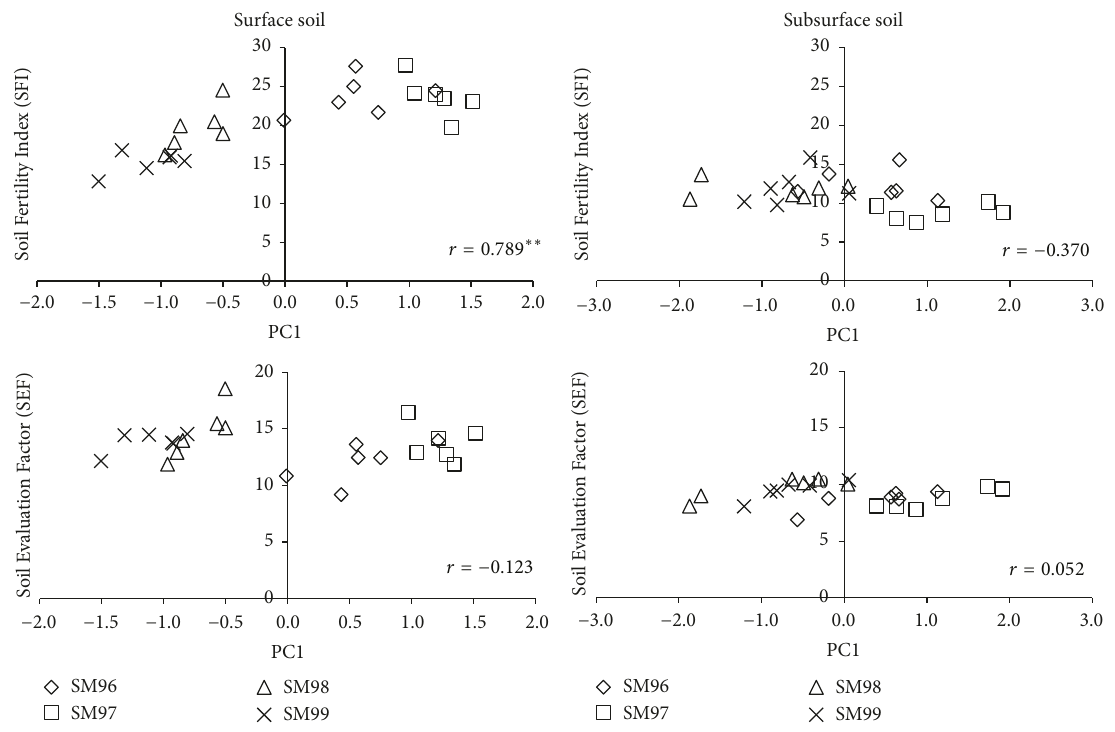
Figure 2: Relationship between PC1 score derived from PCA analysis and the calculated Soil Fertility Index (SFI) and Soil Evaluation Factor (SEF) for surface and subsurface soils. ∗∗ Correlations are significant at 1% level, using Pearson correlation